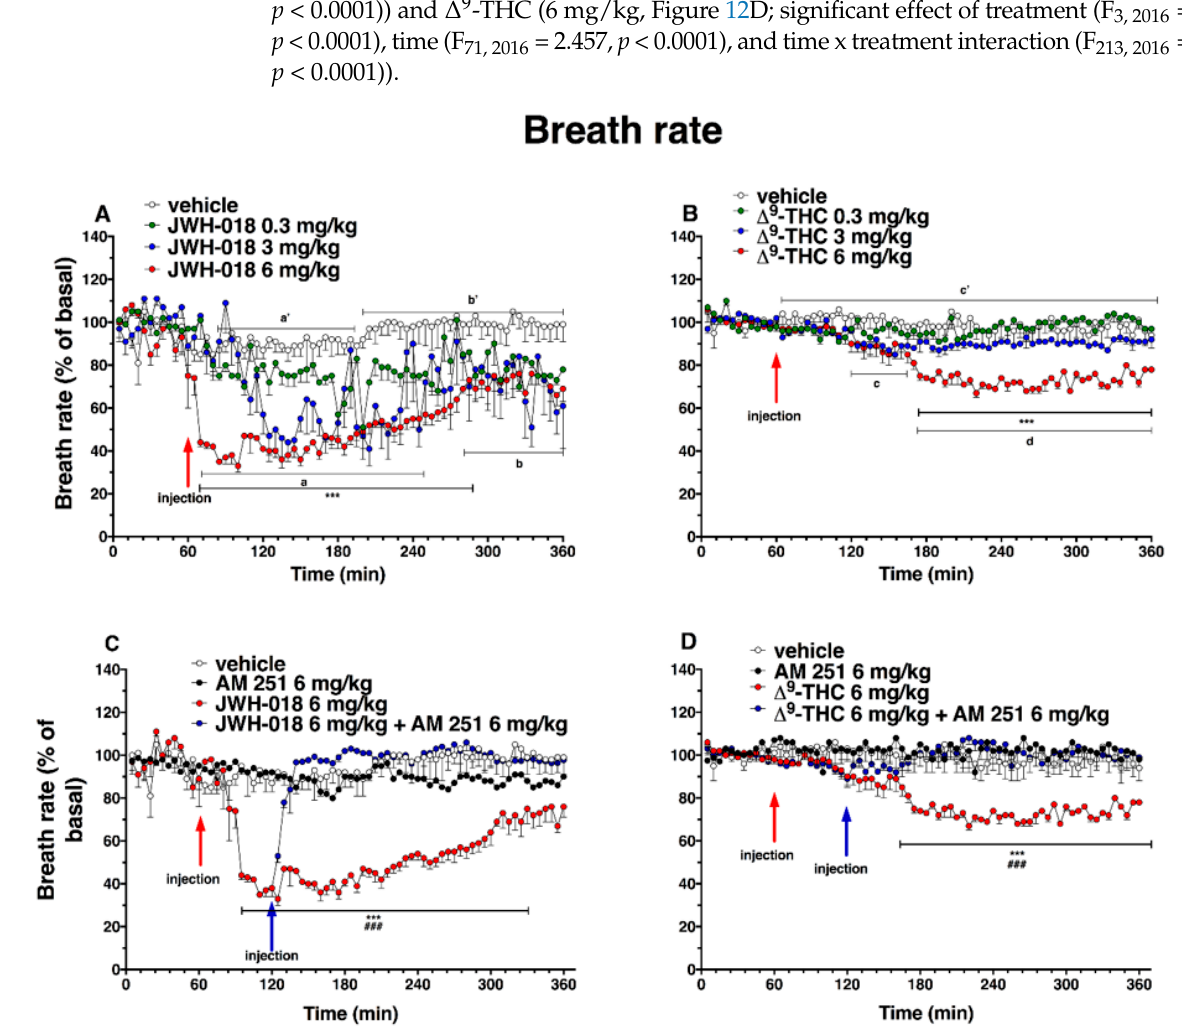
Figure 12. Effect of systemic administration of JWH-018 (0.3–6 mg/kg, panel ( A )) and ∆ 9 -THC (0.3–6 mg/kg, panel ( B )) on breath rate. Data are expressed as percentage of basal values in the form MEAN ± SEM of 6 different evaluations for JWH-018 experiments and MEAN ± SEM of 8 different evaluations for ∆ 9 -THC experiments. Statistical analysis was performed by two-way ANOVA, fol- lowed by Bonferroni’s test for multiple comparisons. *** p < 0.001 versus vehicle. Vehicle and 6 mg/kg dose curves are marked by letters (a’, b’, and c’ for vehicle and a, b, c, and d for 6 mg/kg treatment) to compare effects with plethysmography electrical parameters (Table 2). Interaction of JWH-018 (6 mg/kg i.p, panel ( C )) and ∆ 9 -THC (6 mg/kg i.p, panel ( D )) with the selective CB 1 receptor antagonist AM 251 (6 mg/kg, i.p.). Data are expressed as percentage of basal values in the form MEAN ± SEM of 8 different evaluations for each group. Statistical analysis was performed by two-